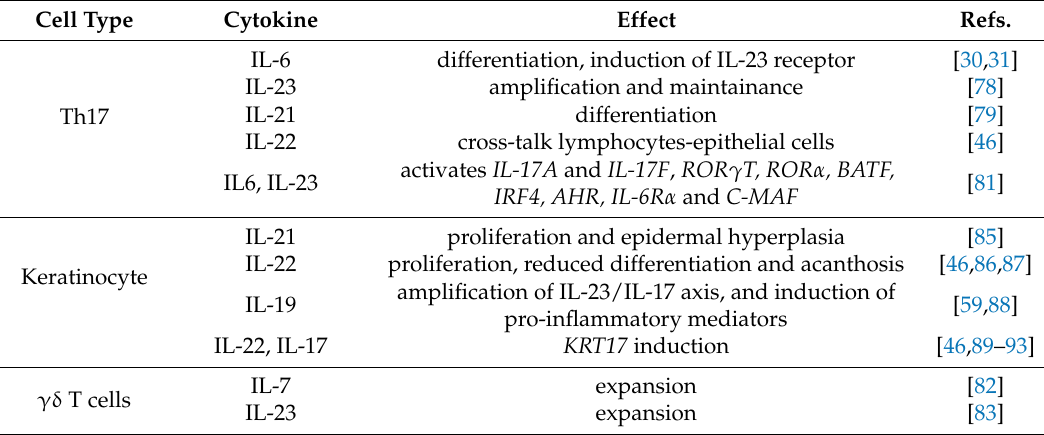
Figure 1. The scheme depicts the main cell types involved in psoriasis pathogenesis, the cytokines/chemokines produced and their target cells. The arrows indicate cytokines that are produced by the different cell types, and the cells where these mainly exert their effector functions. The yellow stars represent events of cytokine-induced STAT3 activation. In the blow-ups, indicated by the dotted lines, the two main cell types involved, Th17 CD4 + T lymphocytes, and keratinocytes, along with details of STAT3-mediated functions and a description of their main pathogenetic features are represented. See text for details and references. Table 1. Biological functions of STAT3 in the main cell types involved in psoriasis pathogenesis. The table reports the cell type, the cytokines shown to activate STAT3 in different contexts, and the main biological functions exerted by this factor in the specific cell type considered. The main references are shown.